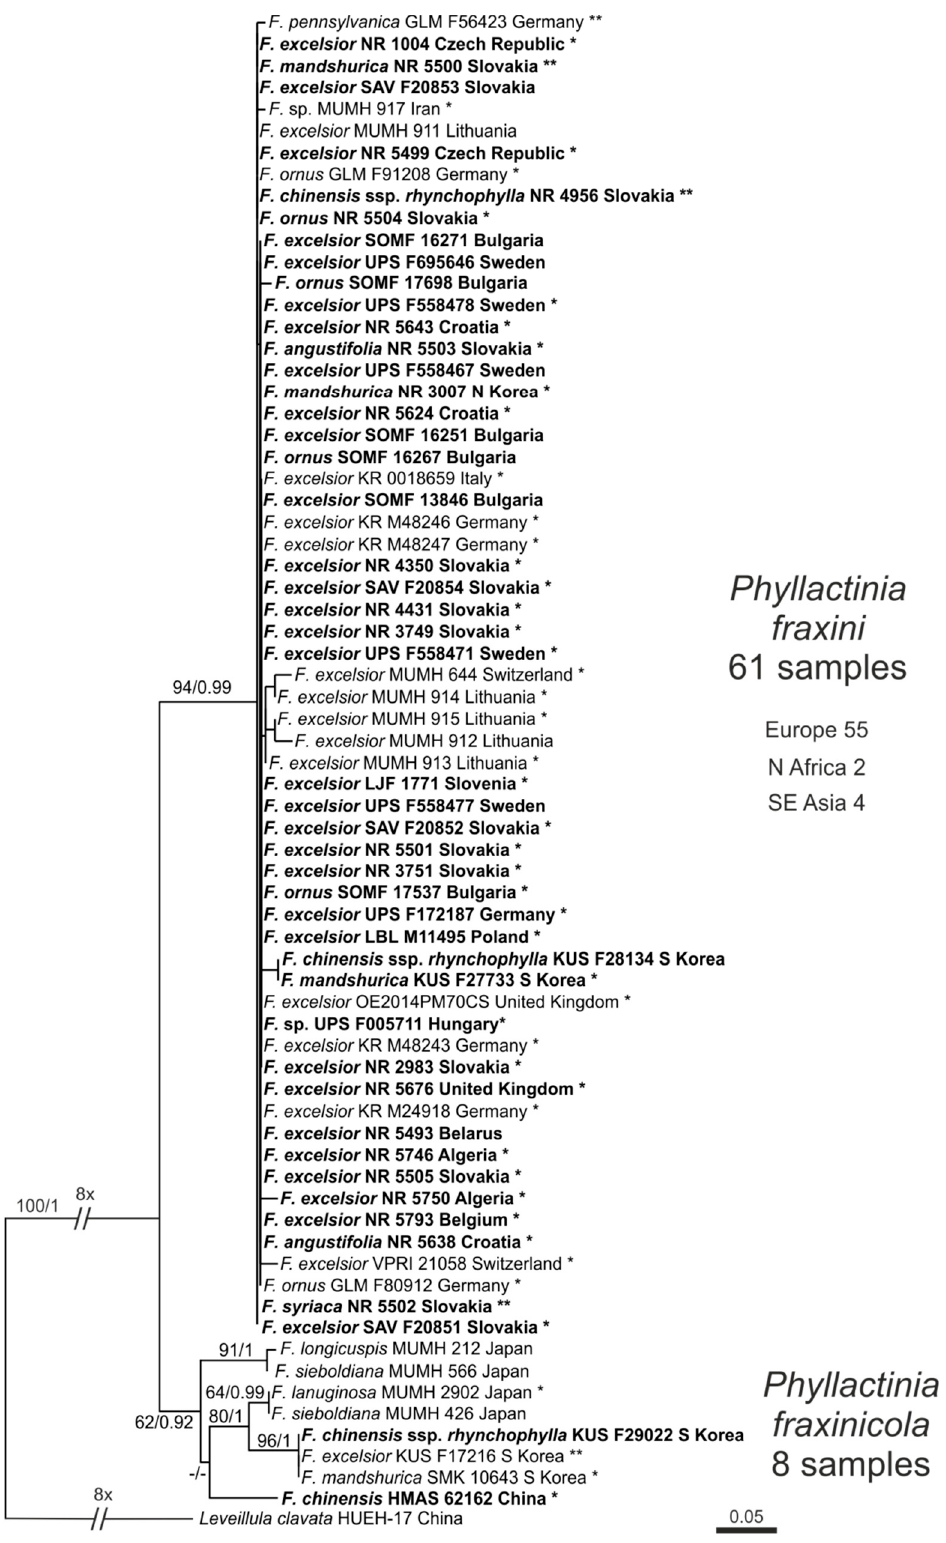
Figure 1. Maximum likelihood (RAxML) phylogeny of the studied Phyllactinia samples inferred from nrITS and nrLSU. The maximum likelihood bootstrap support values greater than 60 and Bayesian posterior probabilities greater than or equal to 0.90 are indicated at nodes. Double slashes indicate a reduction in branch length. * Native ash trees growing in urban environments; ** introduced ash trees growing in urban environments. Specimens in bold were sequenced in this study.